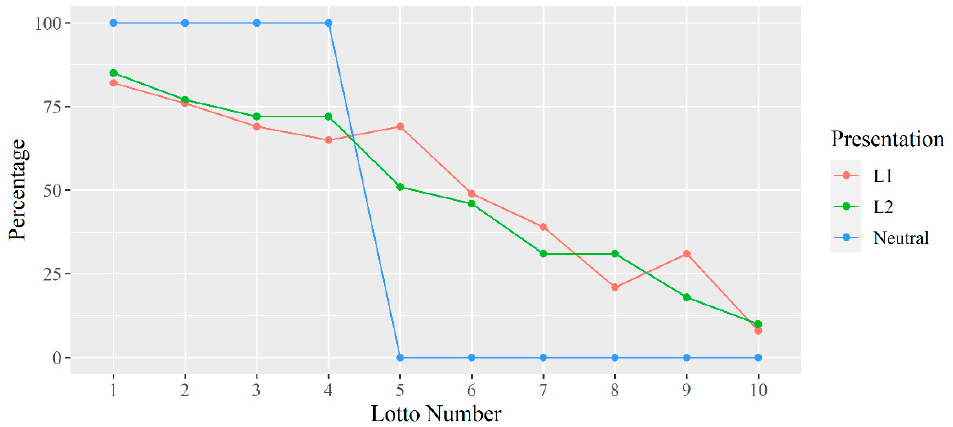
Figure 4. Percentage of “A” choices in the Lotto task.